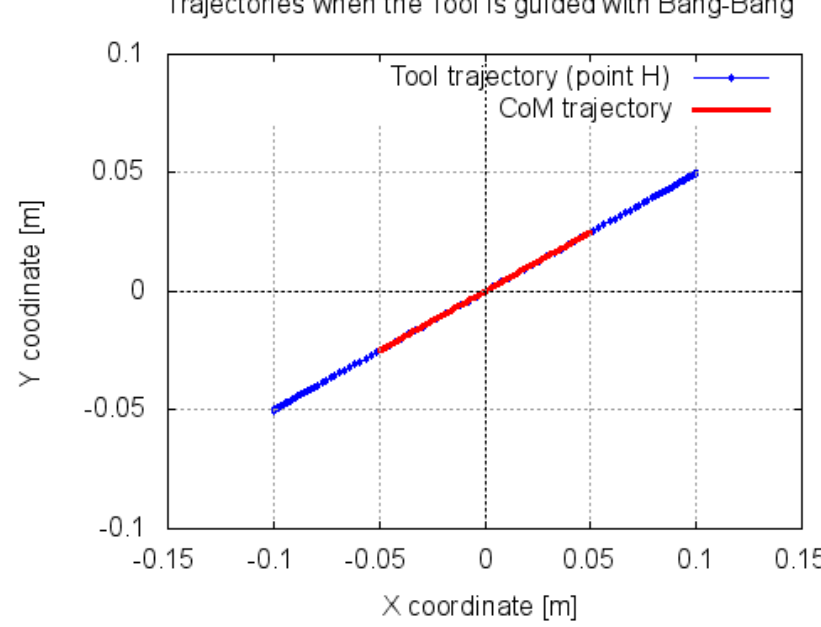
Figure 9. Trajectory imposed to the end-effector in blue and the corresponding generated trajectory of the CoM in red.